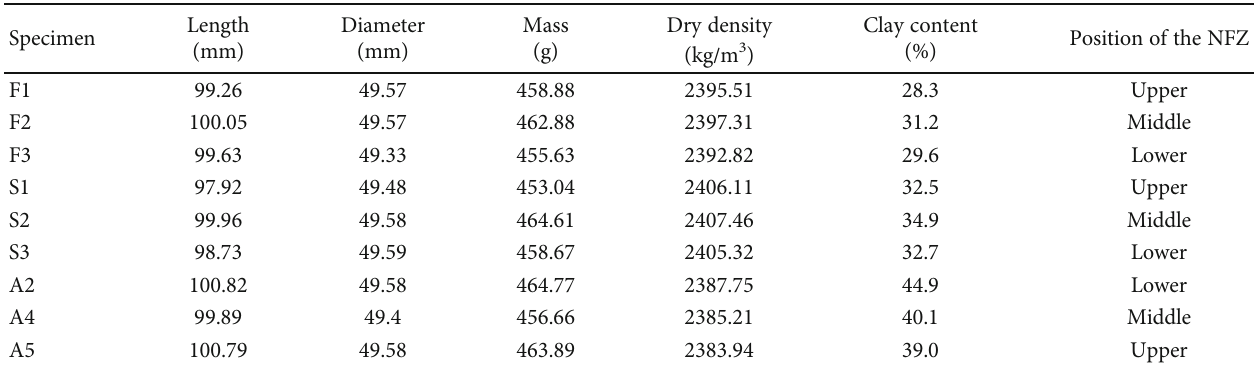
Table 2: Tested sandstone specimens in this research.